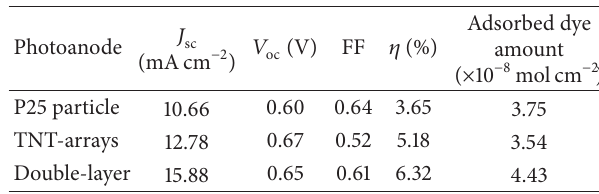
Table 1: Comparisons of the photovoltaic performances and adsorbed dye amount of DSSCs made from P25 nanoparticle film, TNT-arrays films, and double-layer composite film. All measure- ments were performed under AM 1.5 one-sun light intensity of mWcm −2 , and the thickness of all the films was controlled to be similar (ca. 24 𝜇